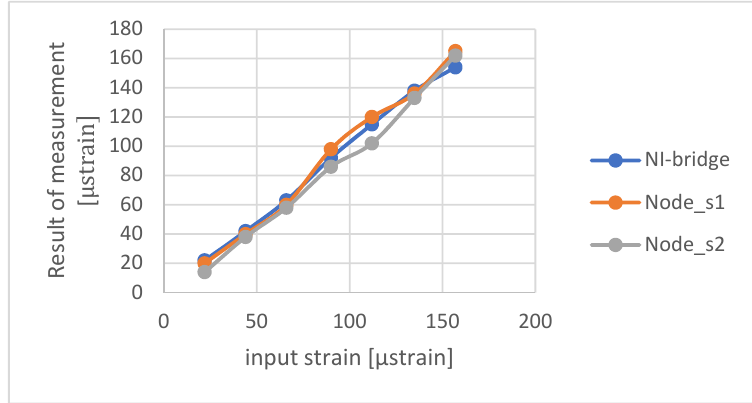
Figure 13. Comparison result of measurements from constructed node and NI 9237 strain bridge.